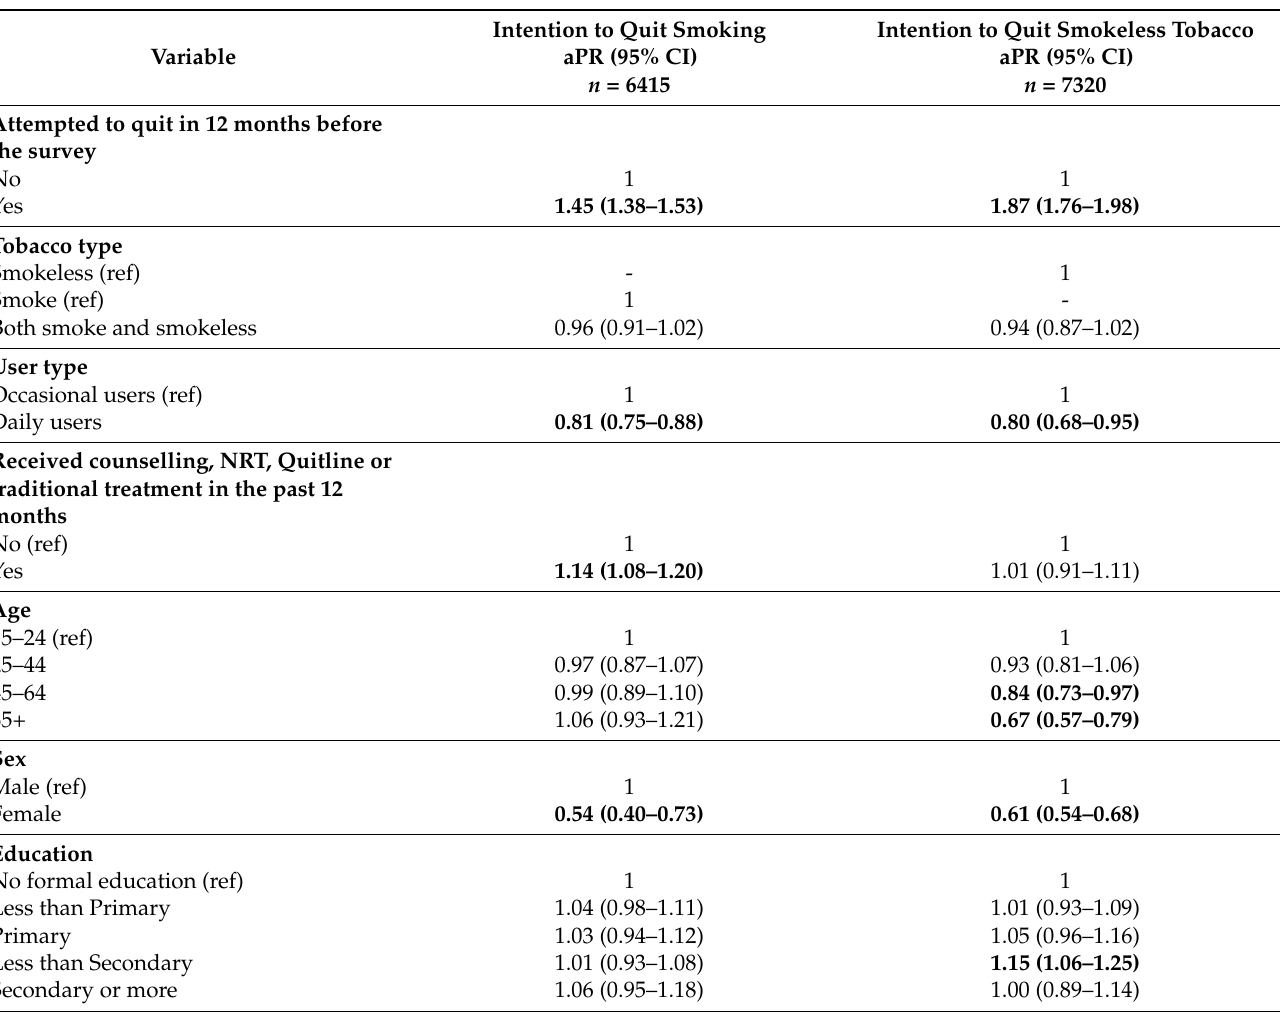
Table 3. Multivariable Poisson regression (with robust variance) examining the associations be- tween intention to quit in the future and quitting attempts during the 12 months before the survey.